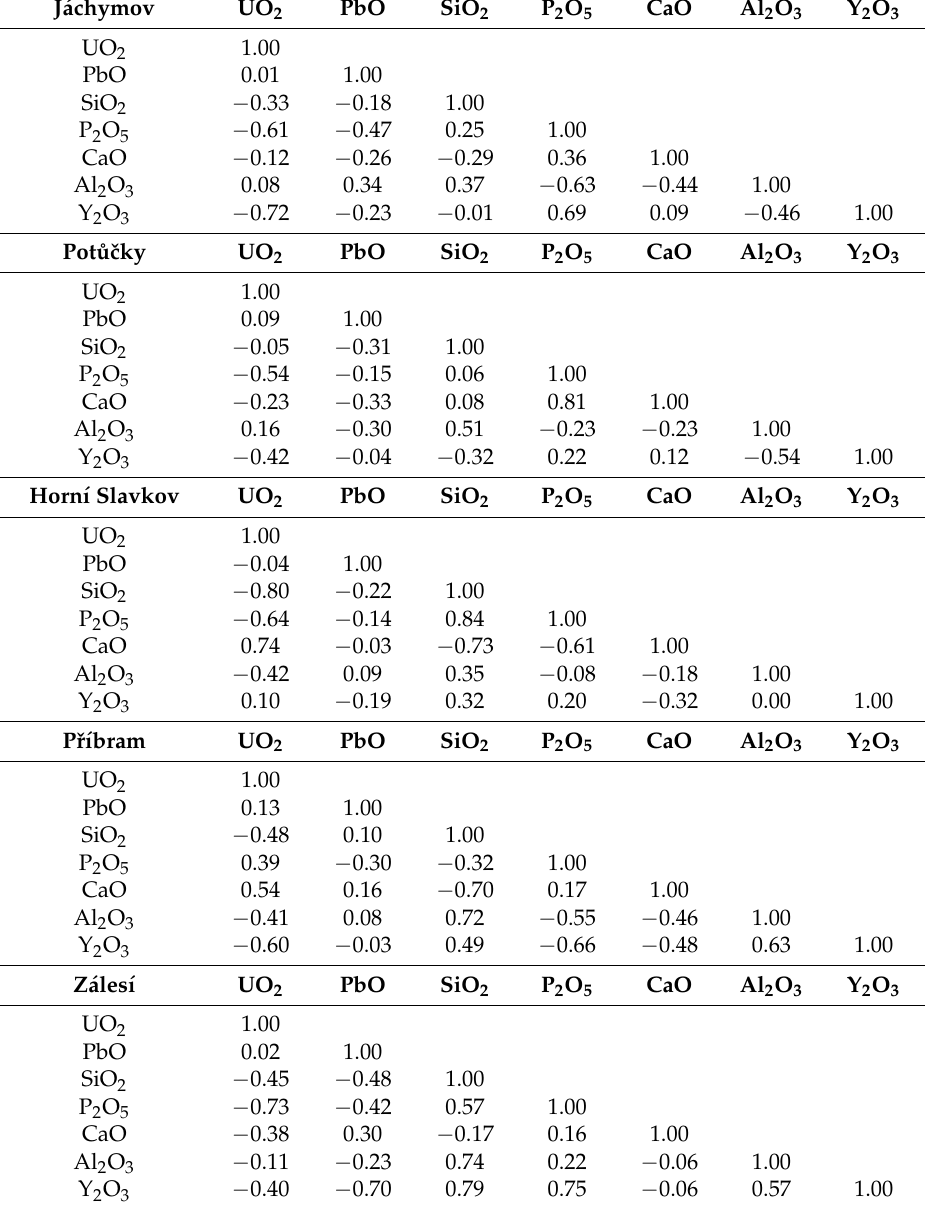
Table 5. Spearman correlation coefficients for selected elements analyzed in